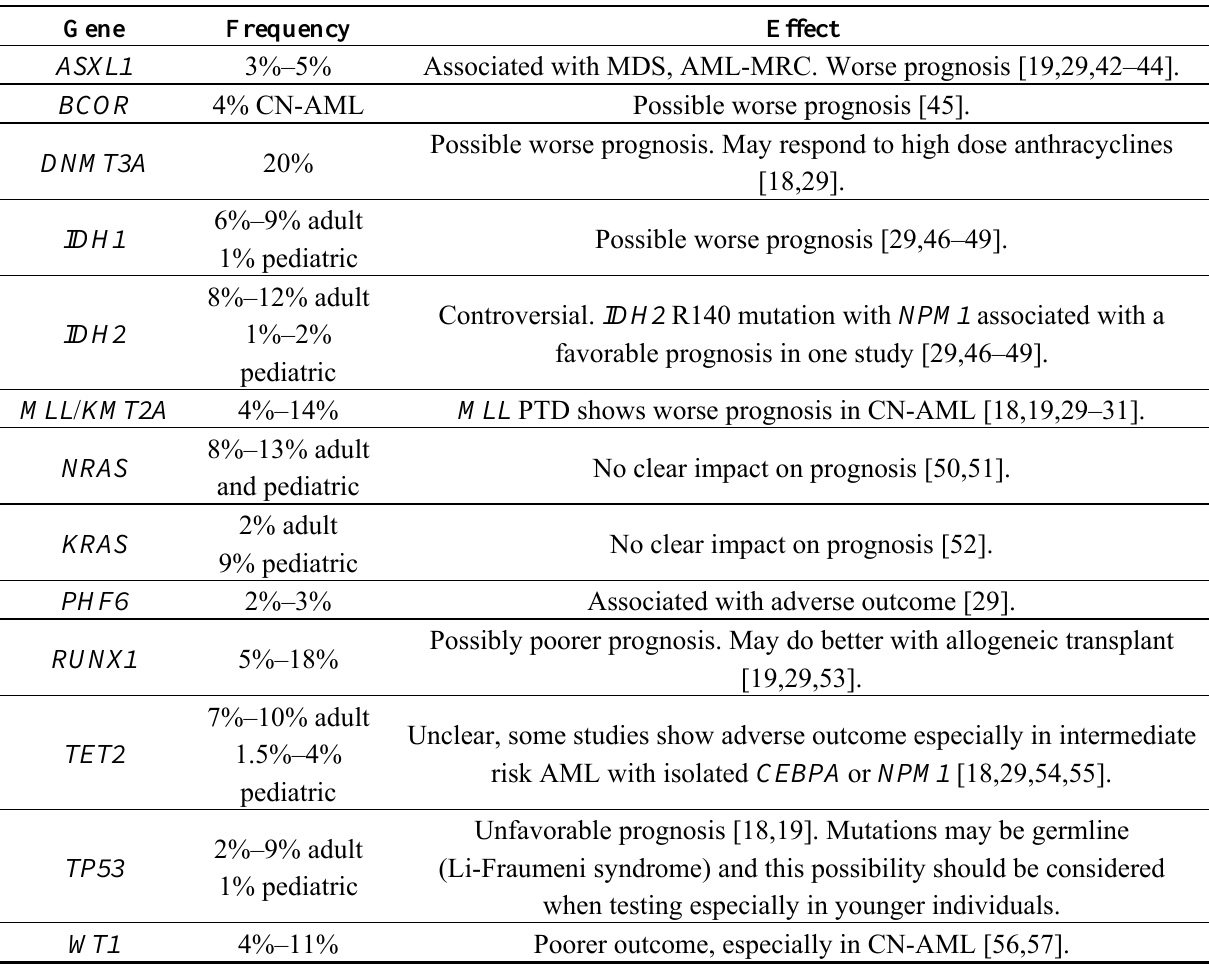
Table 3. Other gene mutations in